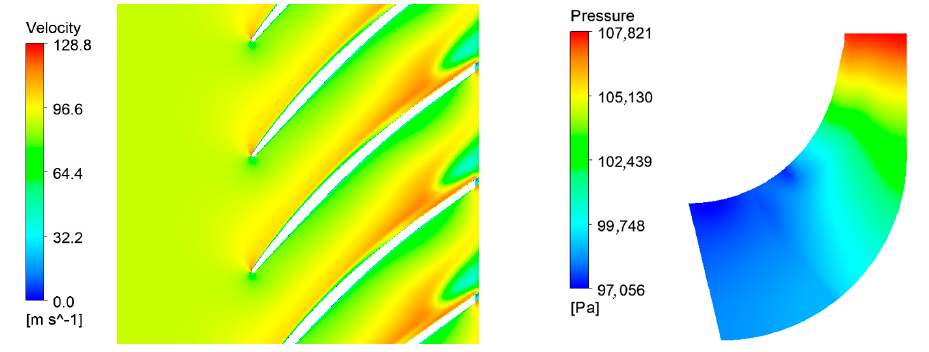
Figure 13. Distribution of velocity and pressure in the TKR 140E impeller. n = 20,760 rpm, middle streamline, mass flow rate—0.3 kg/s.